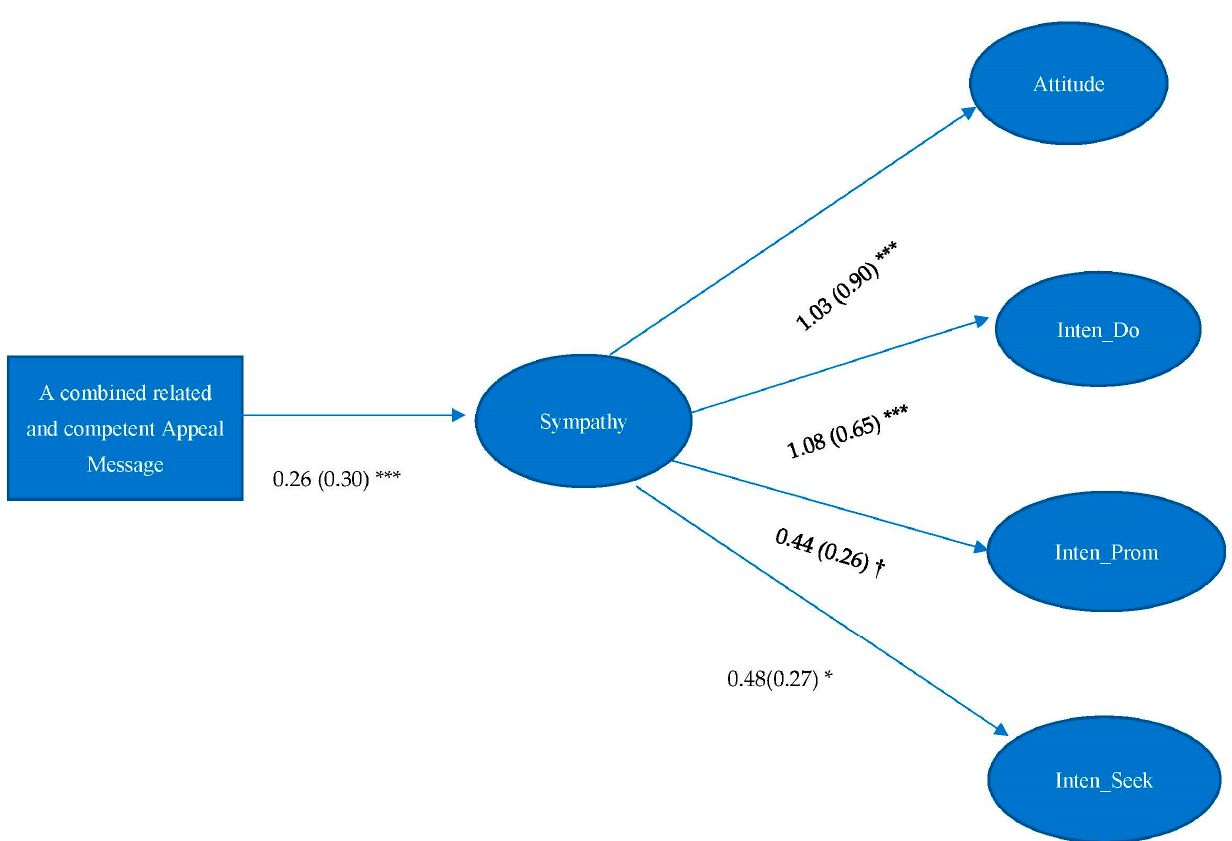
Figure 4. Unstandardized estimates are listed, followed by standardized estimates in parentheses.